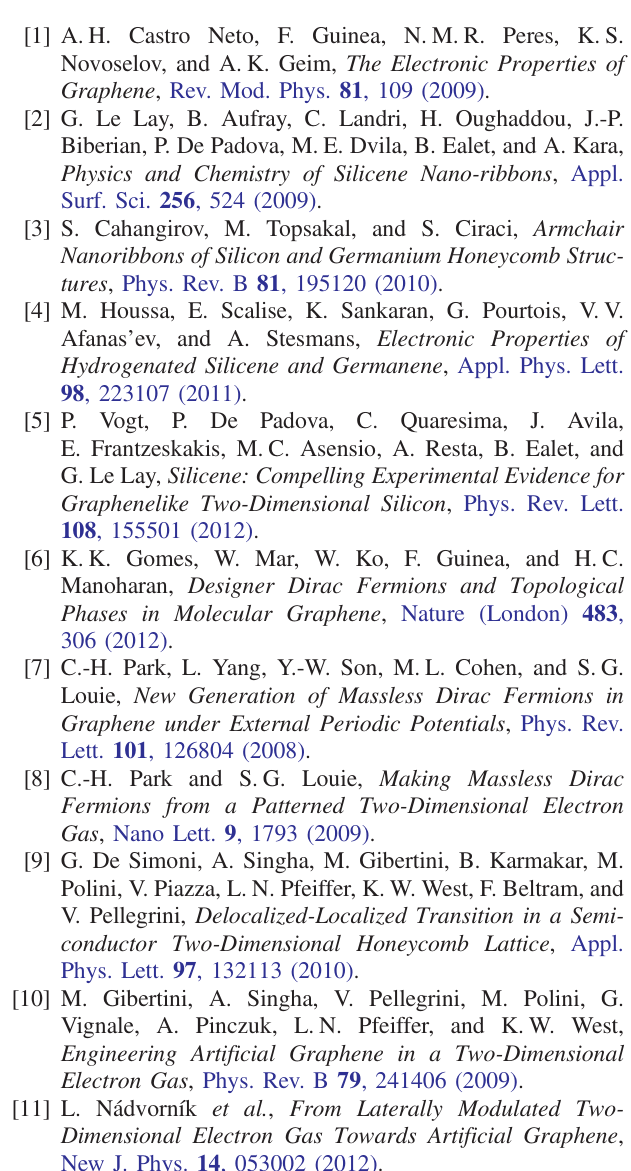
12 (color online). Highest valence bands of a graphene- type honeycomb lattice of truncated nanocubes of CdSe (body diagonalof4.30nm)underamagneticfield B thatinducesZeeman g B ¼ 1 meV).Thecorrespondingbands splitting ofthebands( μ B S at zero magnetic field are those shown in Fig. 2(b). The Chern numbers of the bands are indicated in the